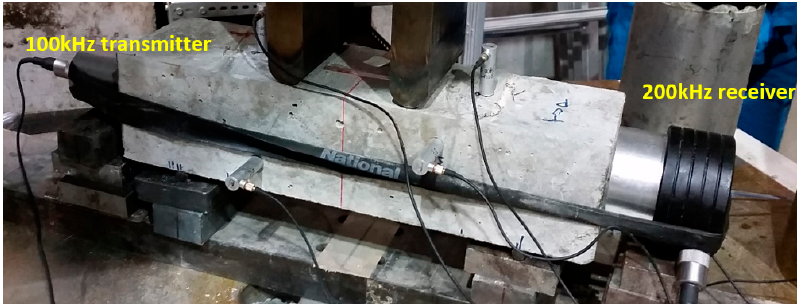
Figure 5. Ultrasonic and four-point bending test setup.